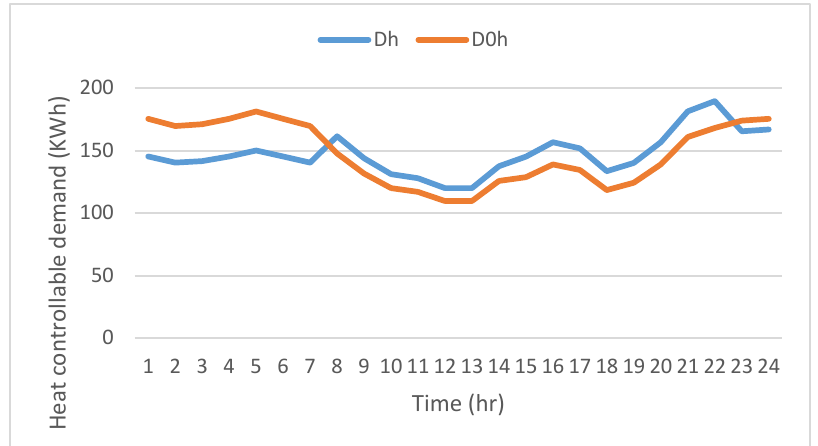
Figure 10. Electrical responsive load profile under the time of use (TOU) policy in a winter working-day for the last year.